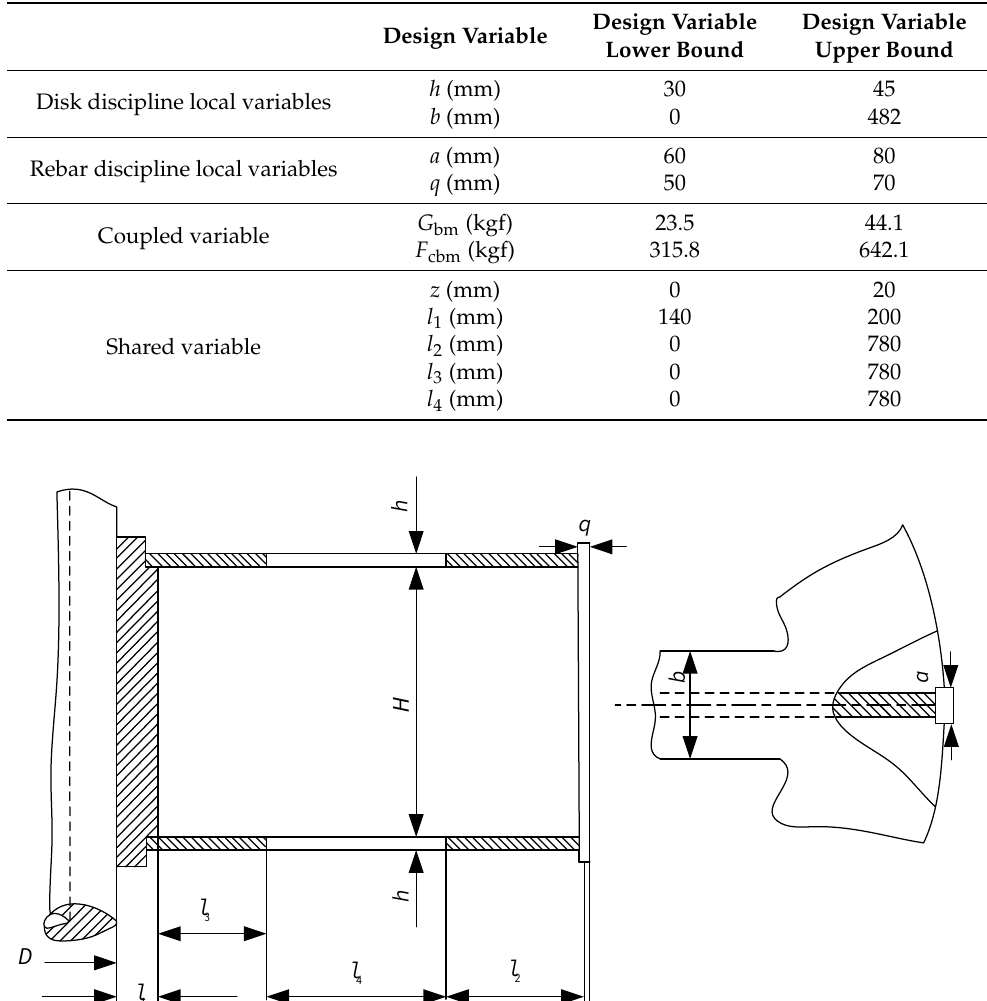
Table 1. Variable information in the rotor mechanism design optimization problem.